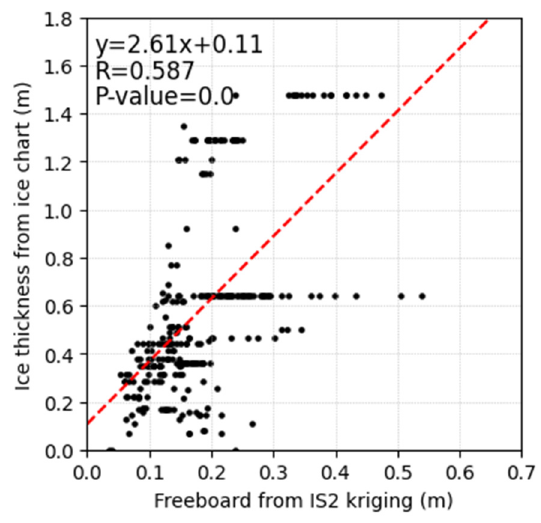
Figure 13. Scatter plot between weekly freeboard estimated by ICESat-2 based kriging and ice thickness from the weekly NIC ice chart for April to November 2019.